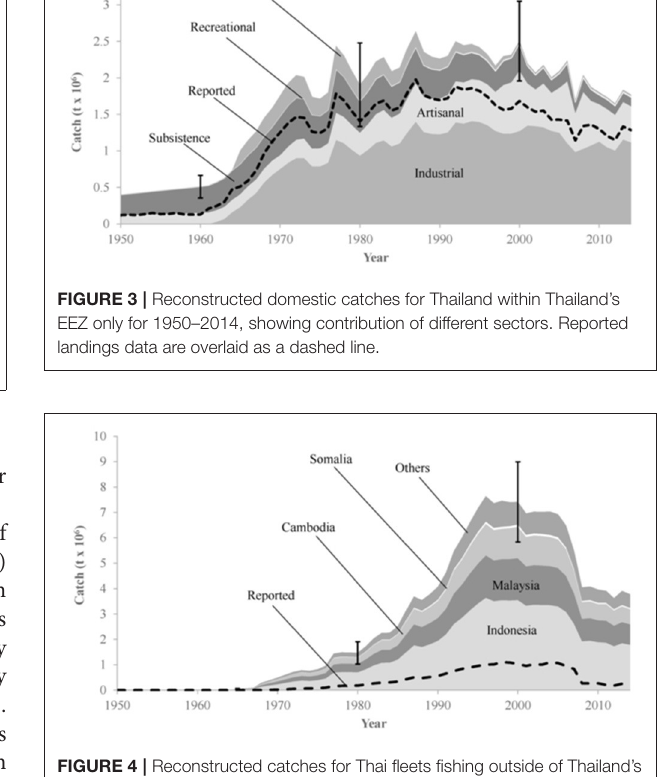
FIGURE 4 | Reconstructed catches for Thai fleets fishing outside of Thailand’s EEZ for 1950–2014. Reported landings data are overlaid as a dashed line, illustrating the poor catch data monitoring and reporting by ‘offshore’ fleets fishing internationally. “Others” includes Myanmar, Bangladesh and India.